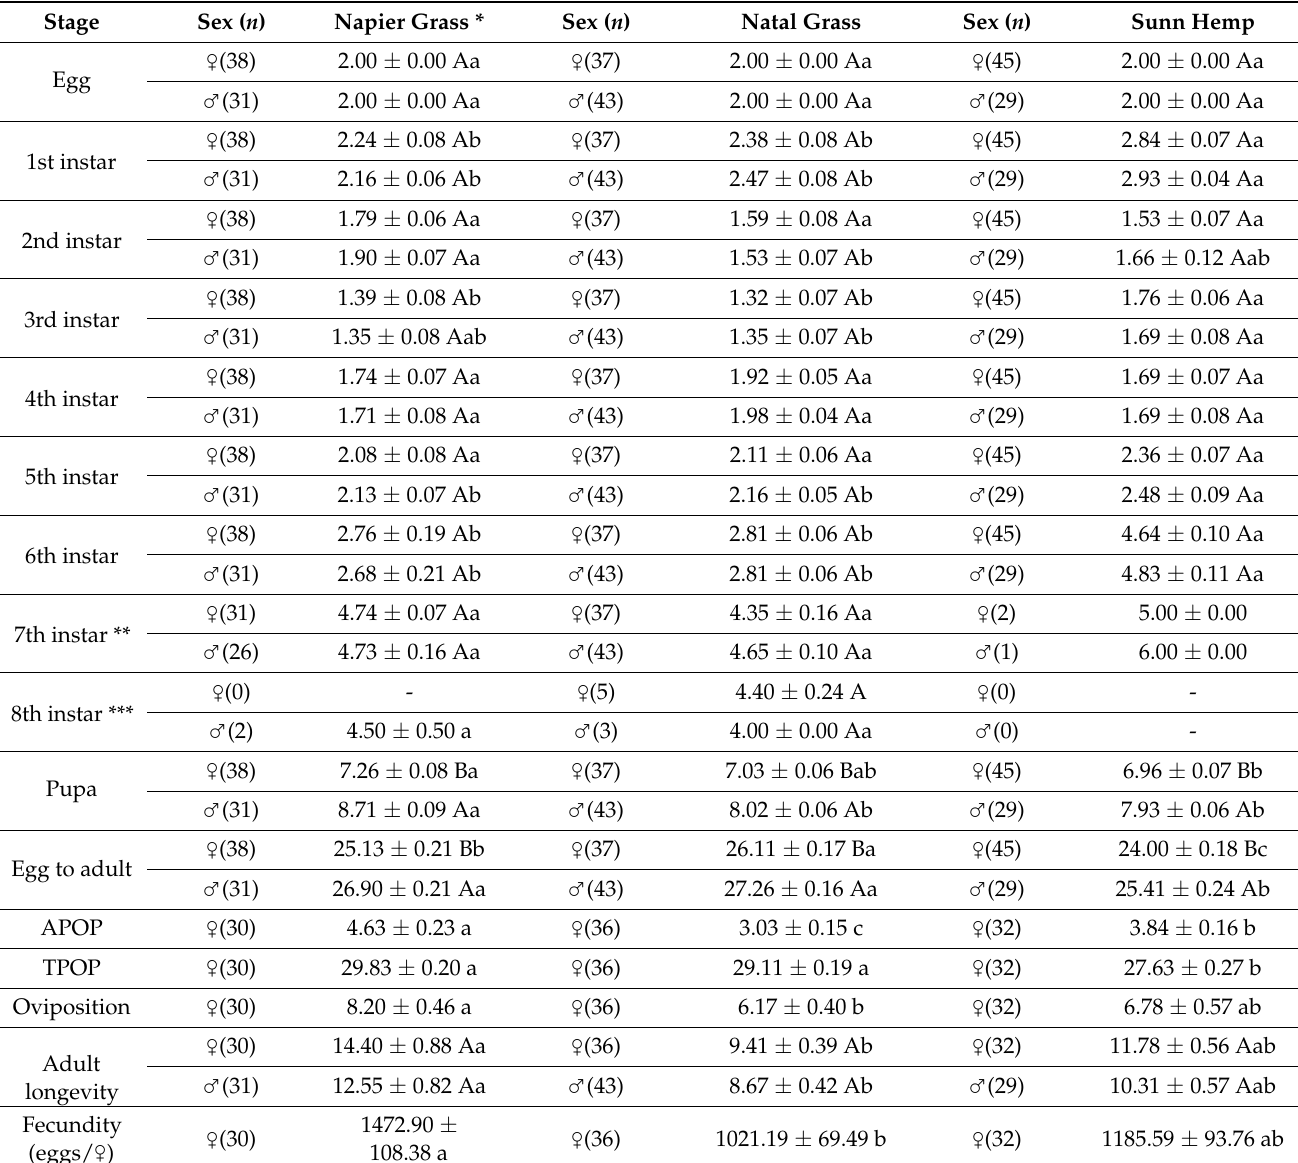
Table 1. Developmental duration, APOP, TPOP, oviposition, adult longevity, and fecundity (mean ± SE) of FAW on different host